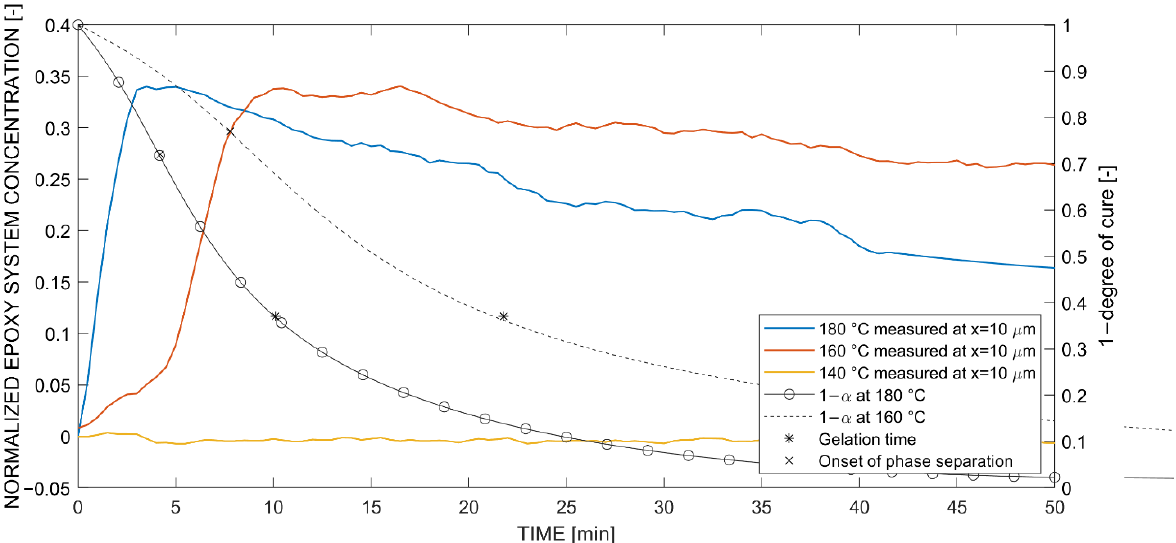
Figure 10. Temperature-dependent concentration curves normalized to Raman intensity amplitude 4504@988 cm −1 at coordinate x = 10 μm (positive) for diffusion of the (reactive multicomponent) epoxy system into PEI.